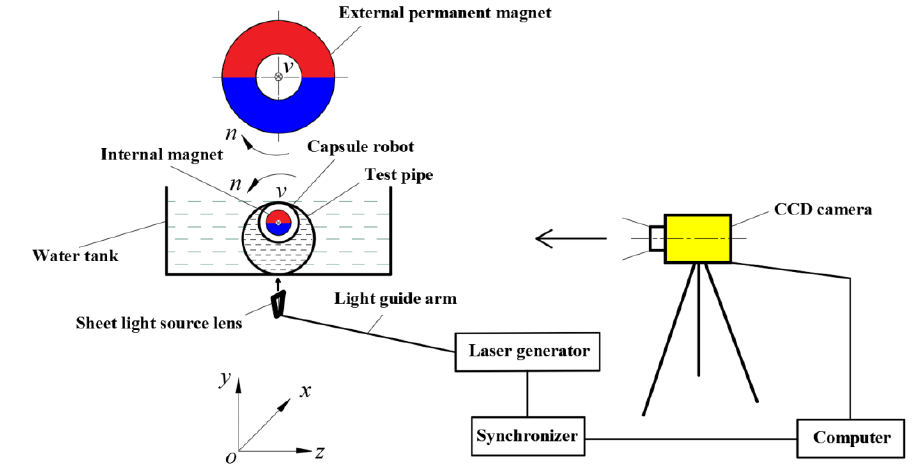
Figure 5. Measurement principle diagram of fluid flow field in the pipe of the capsule robot.